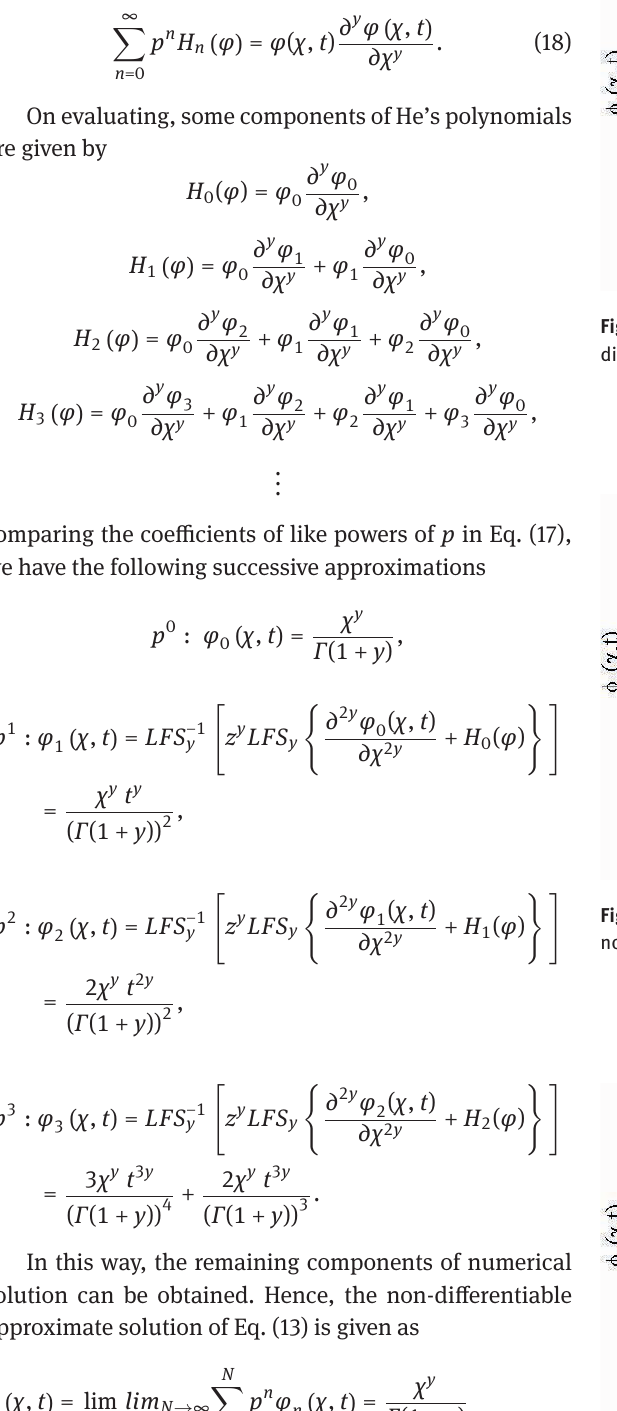
Fig. 3: Numerical simulation of third order approximation with non- differentiable terms when γ = ln2